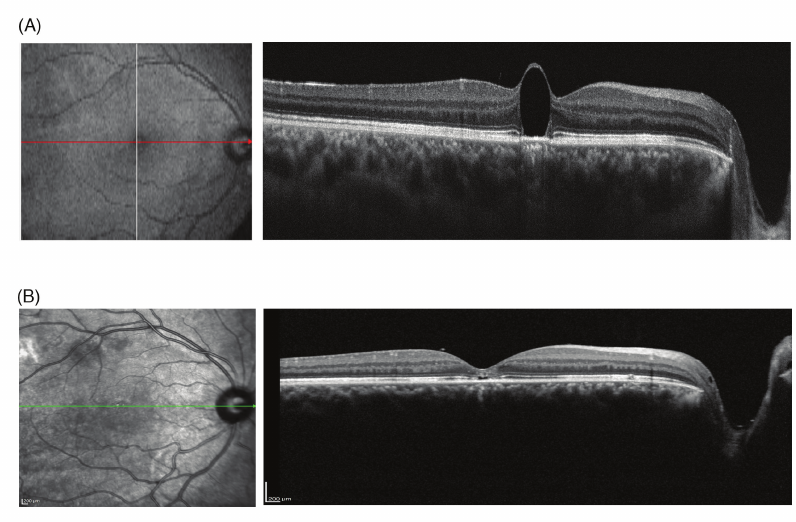
Figure 2. (A) Preoperative optical coherence tomography (OCT) image showing subfoveal perfluorocarbon liquid (PFCL) bubble. (B) Postoperative OCT image, three weeks after surgery showing the complete removal of PFCL bubble. Foveal ellipsoid zone and external limiting membrane disruption are also present.